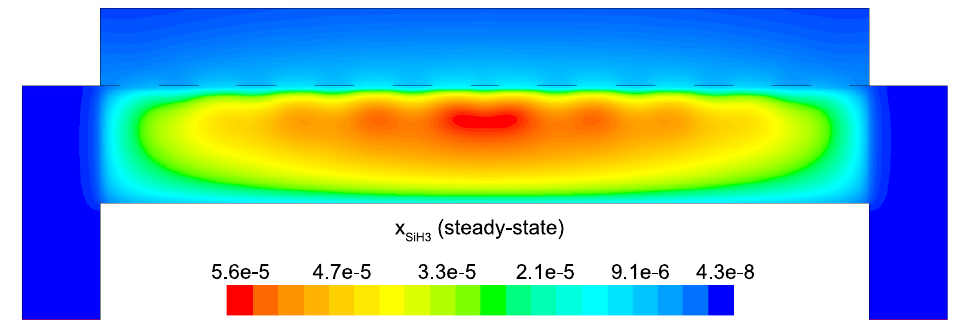
Figure 16. Steady-state profile of x SiH